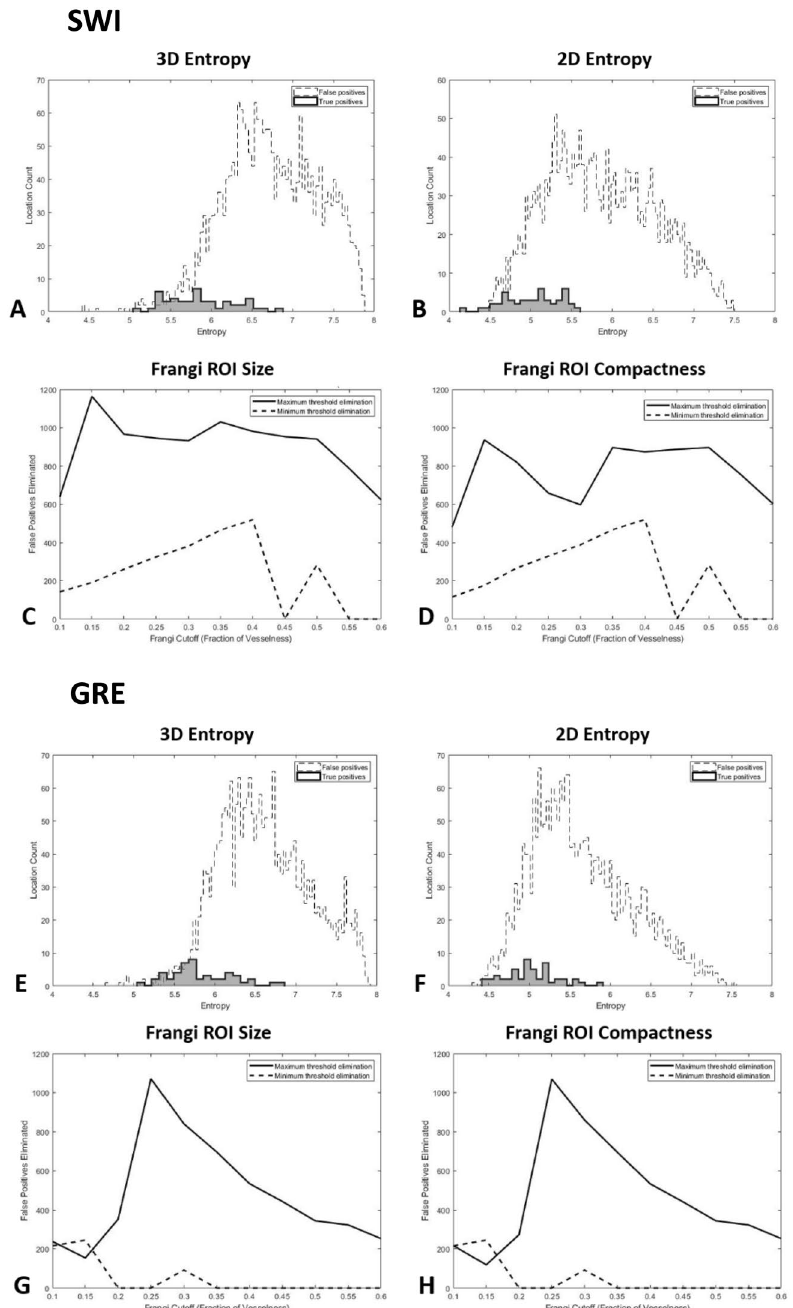
Figure 4. Geometric measure cutoff justifications. This figure illustrates the geometric properties used to remove false positives from the identified locations in SWI and GRE images. Modalities are separated into panels. ( A) Distribution of 3D entropy in the ROI neighborhood on SWI. ( B) Distribution of the 2D entropy of the maximum intensity projection of the ROI neighborhood on SWI. ( C) Number of false positives removed at different cutoffs of the Frangi vesselness measure based on the central blob volume on SWI. ( D) Number of false positives removed at different cutoffs of the Frangi vesselness measure based on the central blob compactness on SWI. ( E) Distribution of 3D entropy in the ROI neighborhood on GRE. ( F) Distribution of the 2D entropy of the maximum intensity projection of the ROI neighborhood on GRE. ( G) Number of false positives removed at different cutoffs of the Frangi vesselness measure based on the central blob volume on GRE. ( H) Number of false positives removed at different cutoffs of the Frangi vesselness measure based on the central blob compactness on